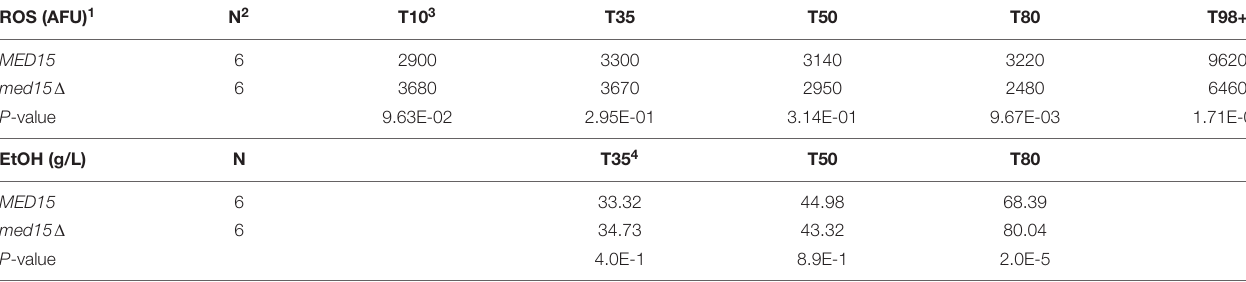
TABLE 4 | Reactive Oxygen Species and Ethanol Levels in WGJ-AA at Weight Loss Benchmarks. ROS (AFU)